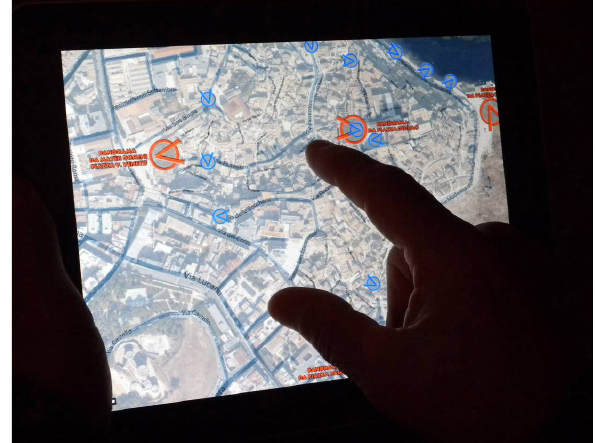
Figure 4. The interactive map with the views through the time indicated with orange and blue icons.